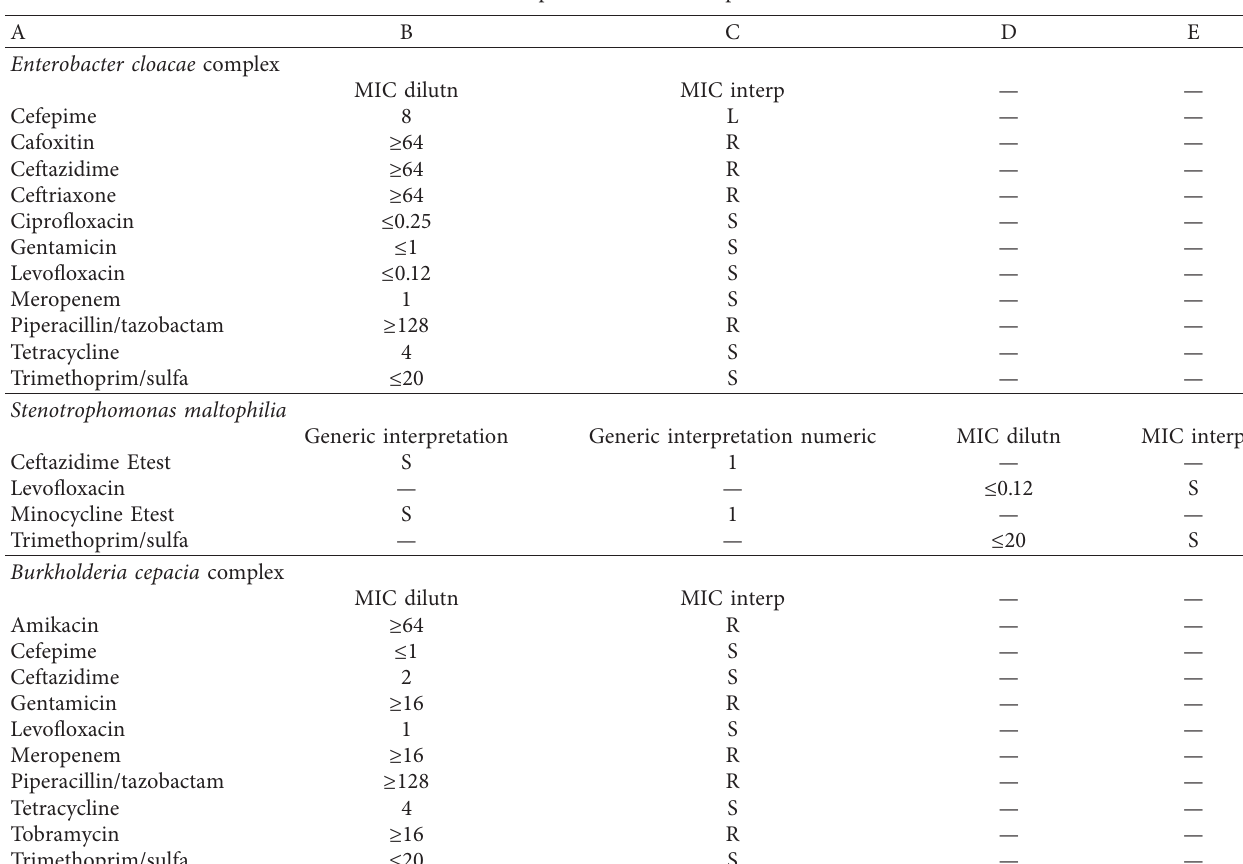
Table 2: Sputum culture